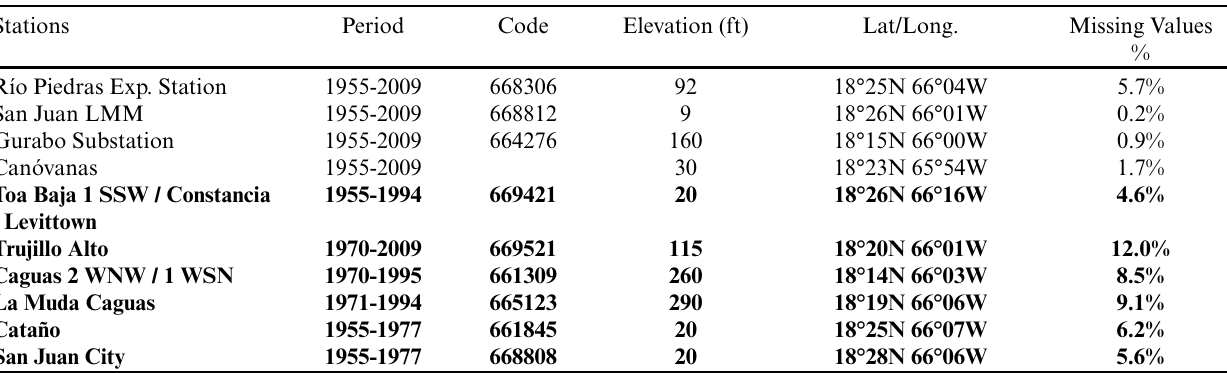
Table 1 . Weather stations within the San Juan metropolitan area.